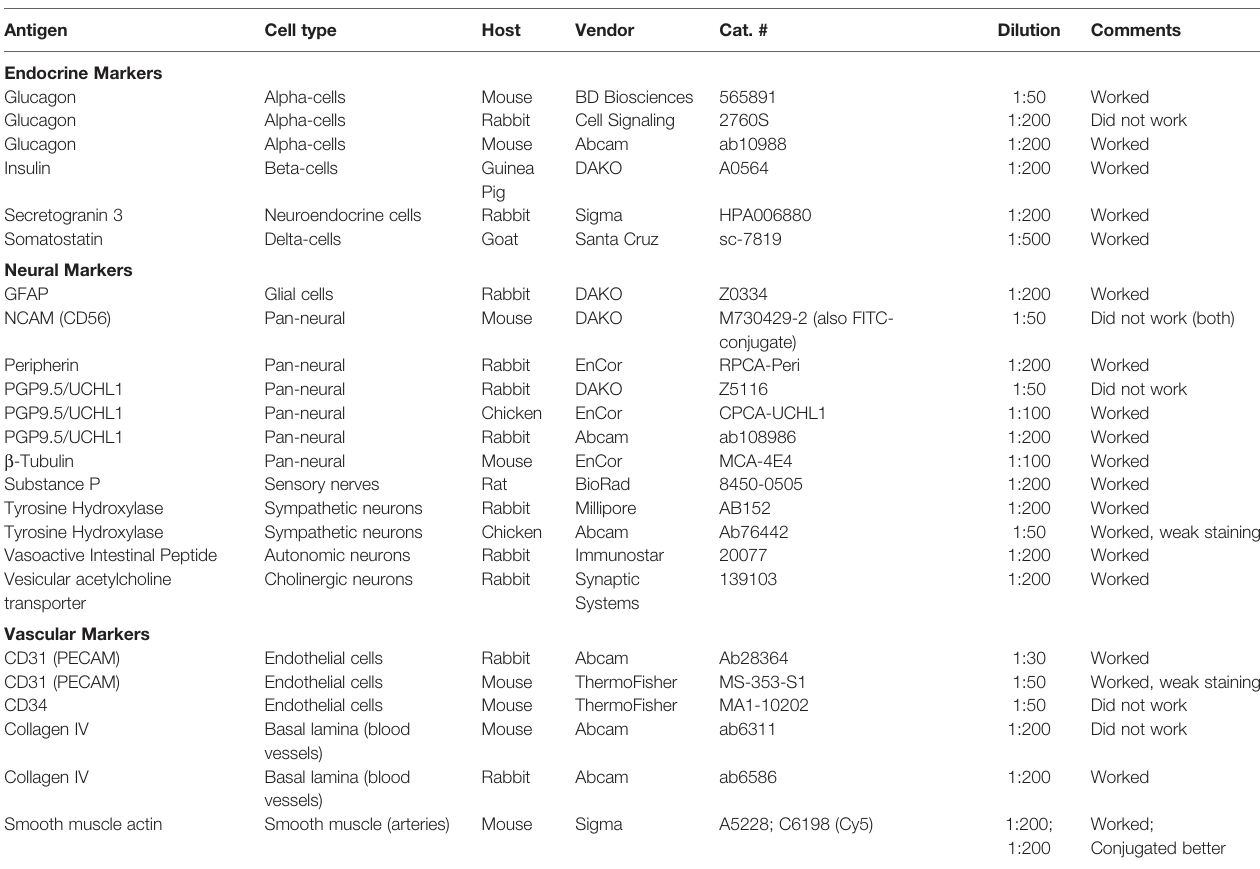
TABLE 2 | Primary antibodies for optical